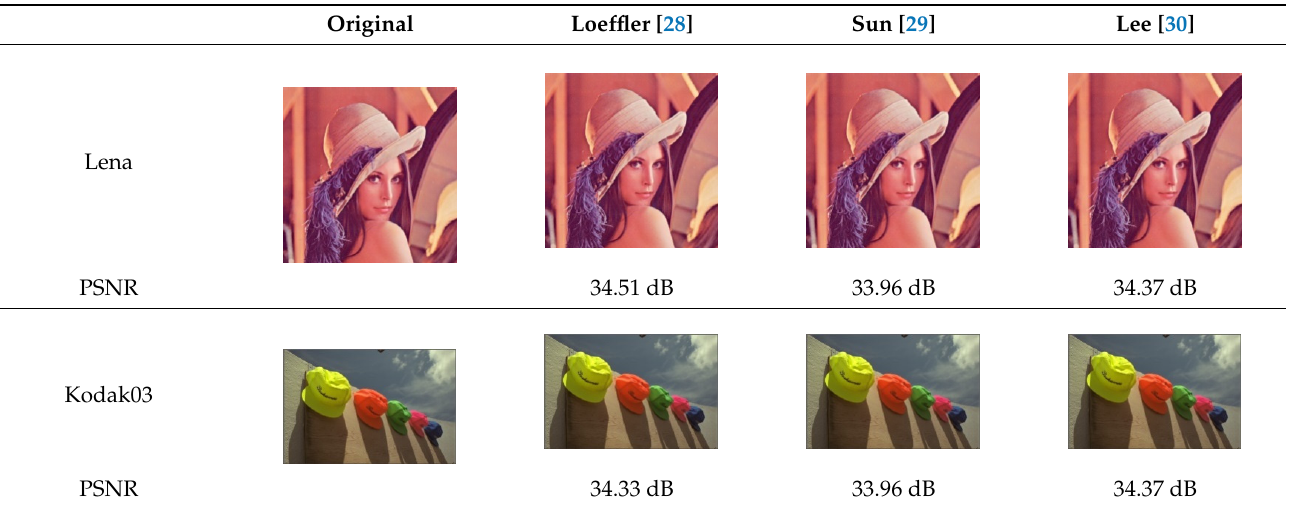
Table 6. Image and PSNR comparisons between previous DCT algorithms and this work.